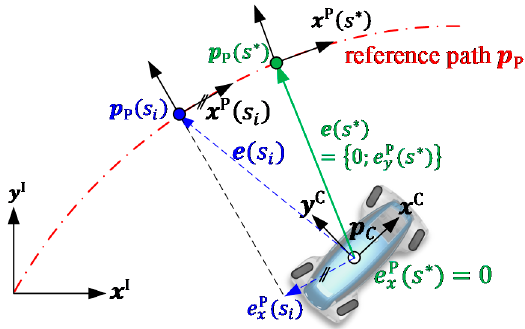
Figure 4. Graphical representation of the dynamic root finding to determine 𝑠 ∗ .